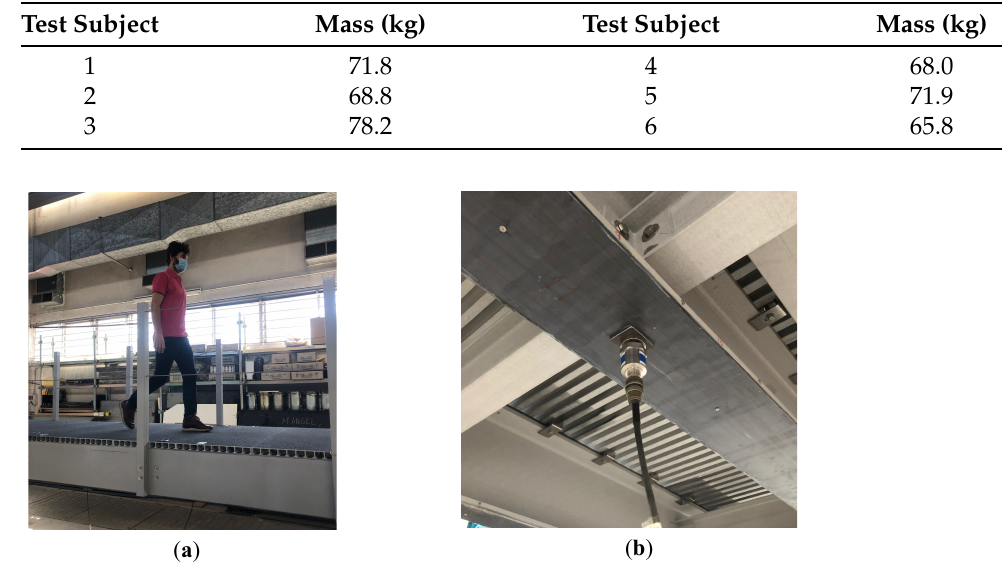
Table 2. Mass of the tests subjects.